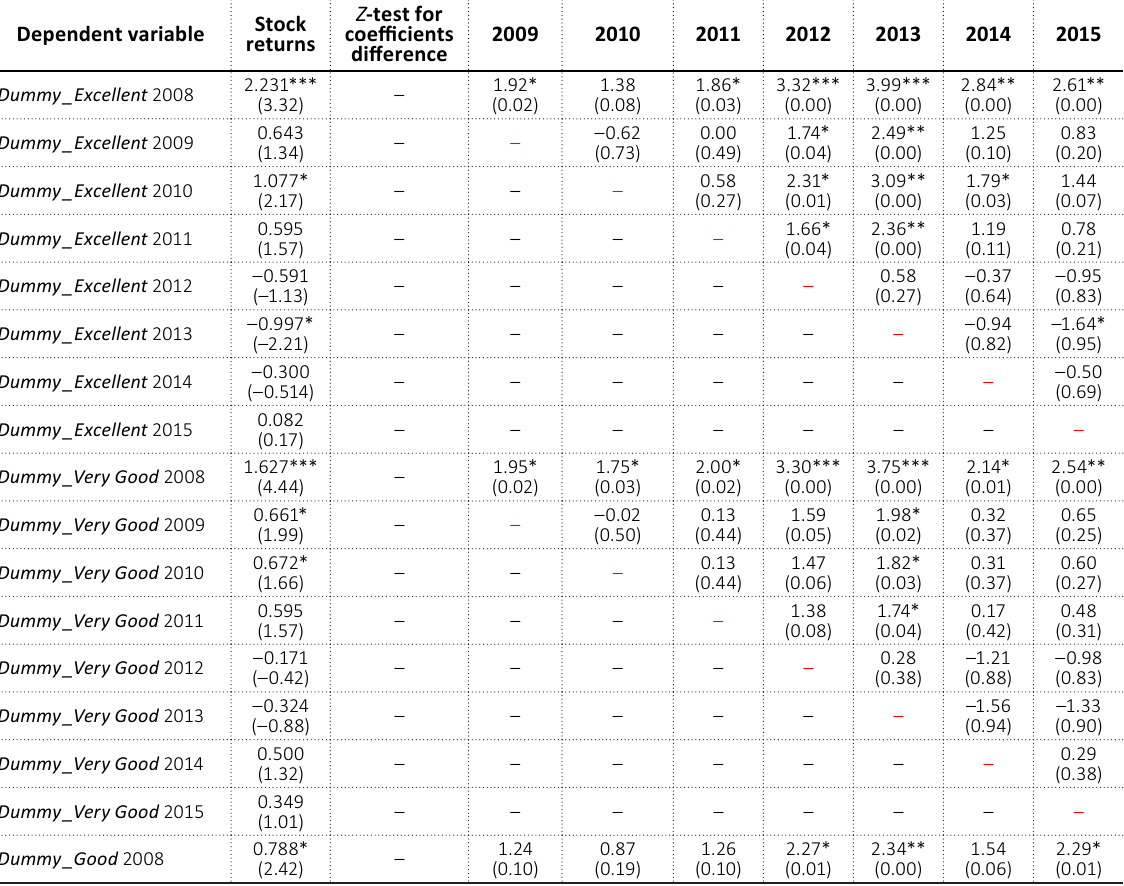
Table 4. Fixed effects regression of stock returns on corporate governance by dummy variables